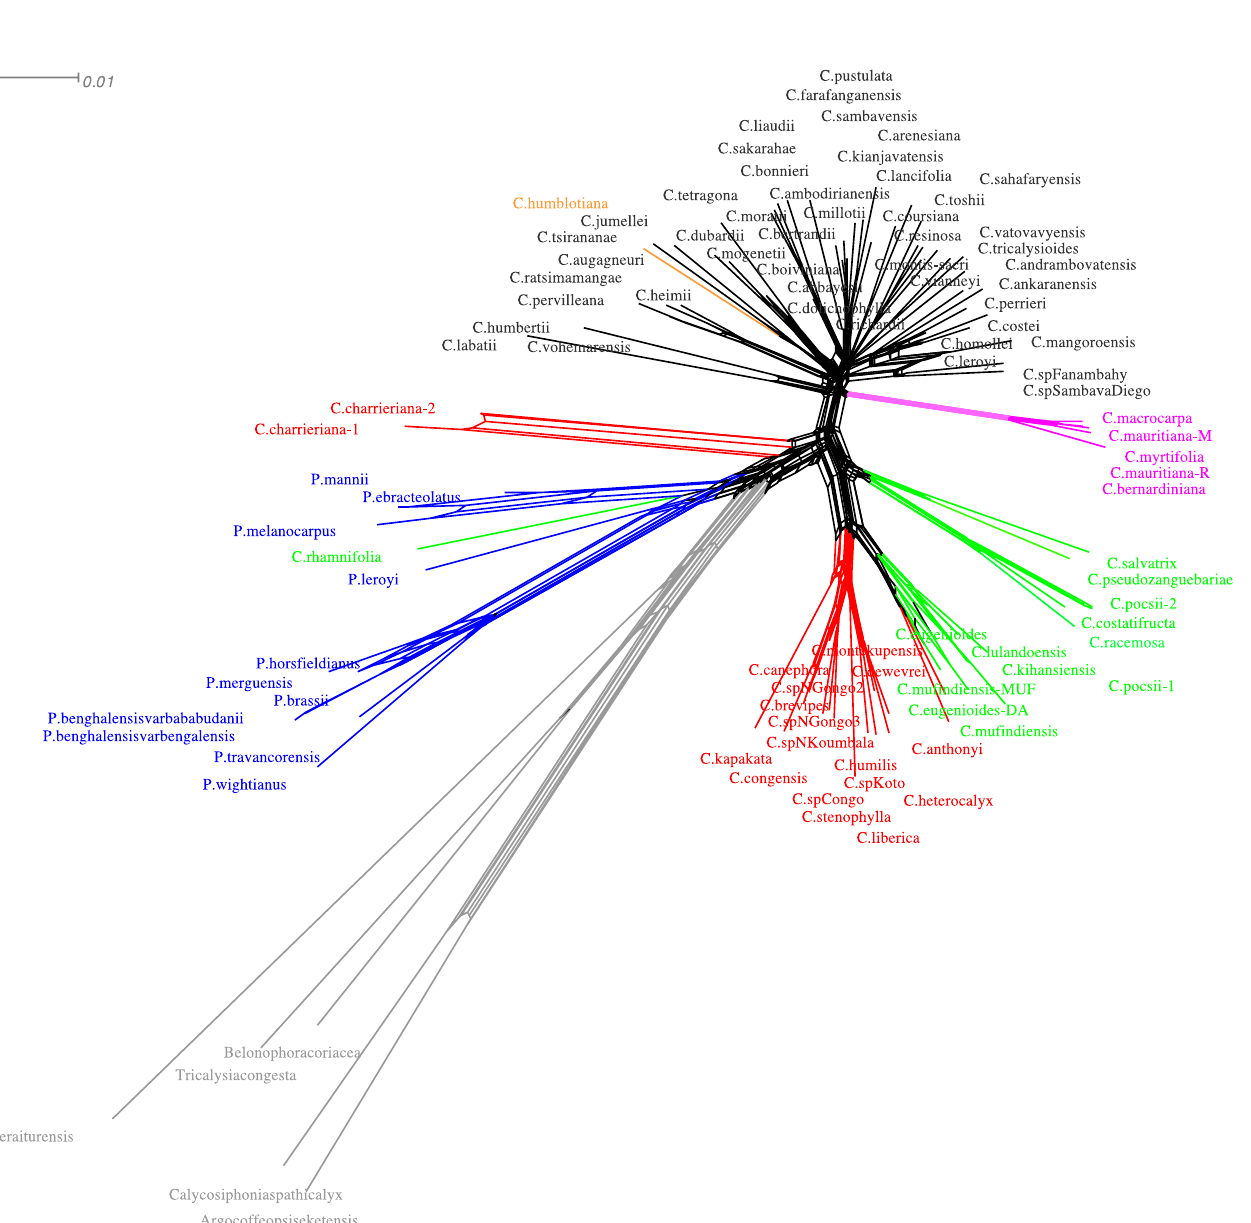
PLOS ONE | https://doi.org/10.1371/journal.pone.0216347 June 12,